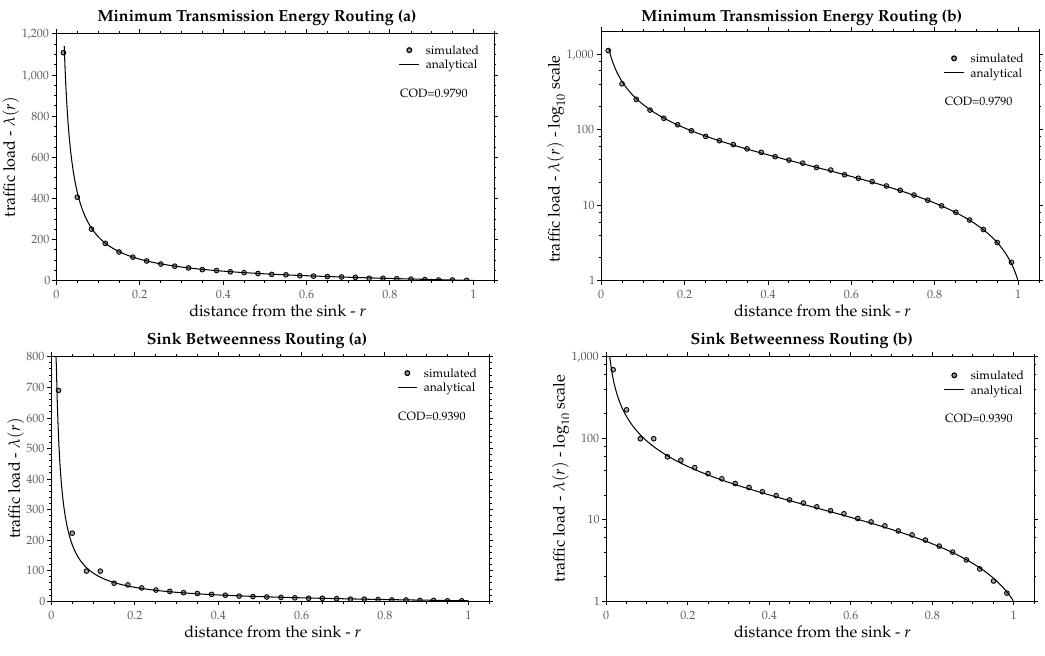
Figure 12. Comparison between Equation (25) and the simulated traffic load as a function of the distance from the sink, for two routing schemes, Minimum Transmission Energy and Sink Betweenness. ( a ) normal (linear) plot, ( b ) semi-log plot